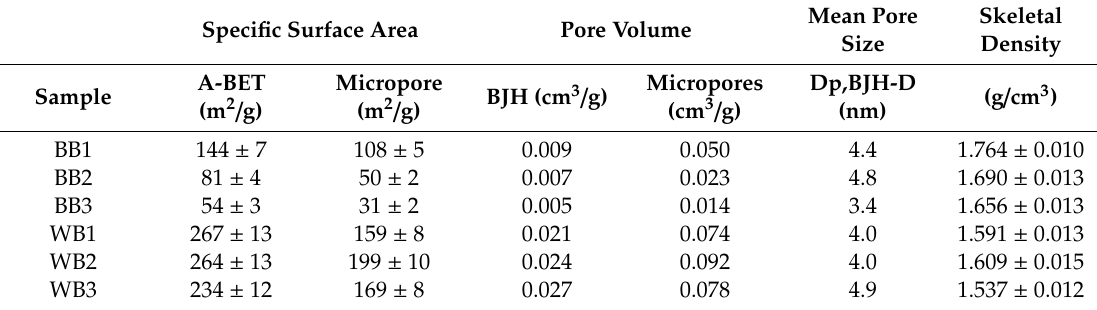
Figure 2. Comparison of the SEM micrograph magnifications at 300 × and 800 × of BB1 and WB1 as examples of bamboo biochar ( a , b ) and pinewood biochar ( c , d ), respectively. Scanning electron microscope image of sample BB1 at ( a ) 300 µ m and ( b ) 100 µ m resolution and sample WB1 at ( c ) 300 µ m and ( d ) 100 µ m resolution. Table 3. Porosity and specific surface area of bamboo biochar (BB) and pinewood biochar (WB) with three replicates each (1, 2 and 3).